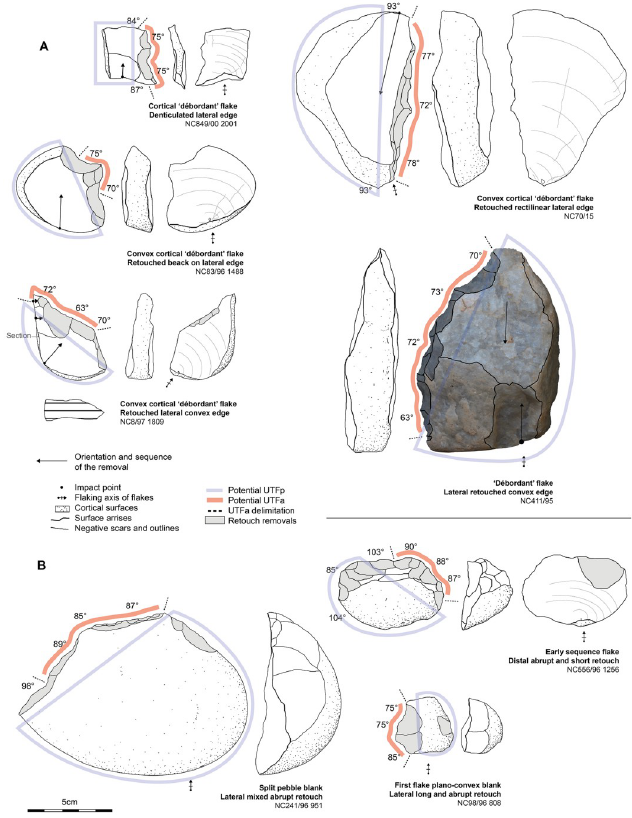
Fig 9. Examples of flake tools from Dungo IV. A: retouched flakes with lateral back interpreted as potentially prehensile part opposite to various retouched edges. B: plano-convex cortical flake blanks with abrupt retouch.